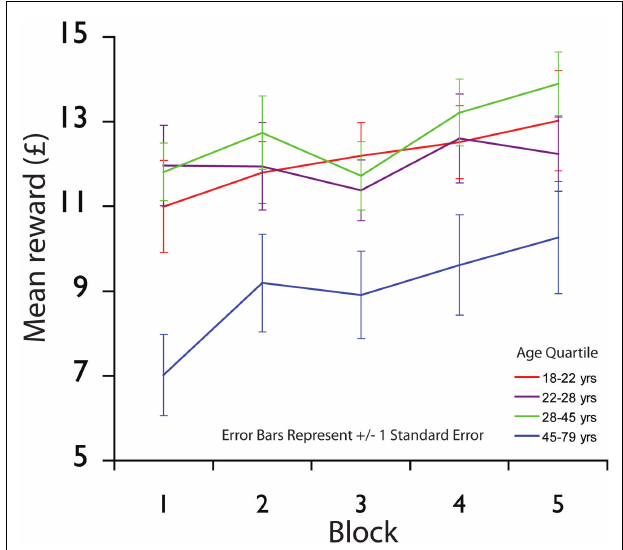
FIGURE 5 | Mean reward per block across blocks. Mean reward per block across blocks, shown by age quartiles in order to graphically illustrate the quadratic effect of age and block number on mean reward per block. In numerical terms performance improved across blocks, although the effect was not significant. Older participants showed steeper improvement in performance than younger participants during early